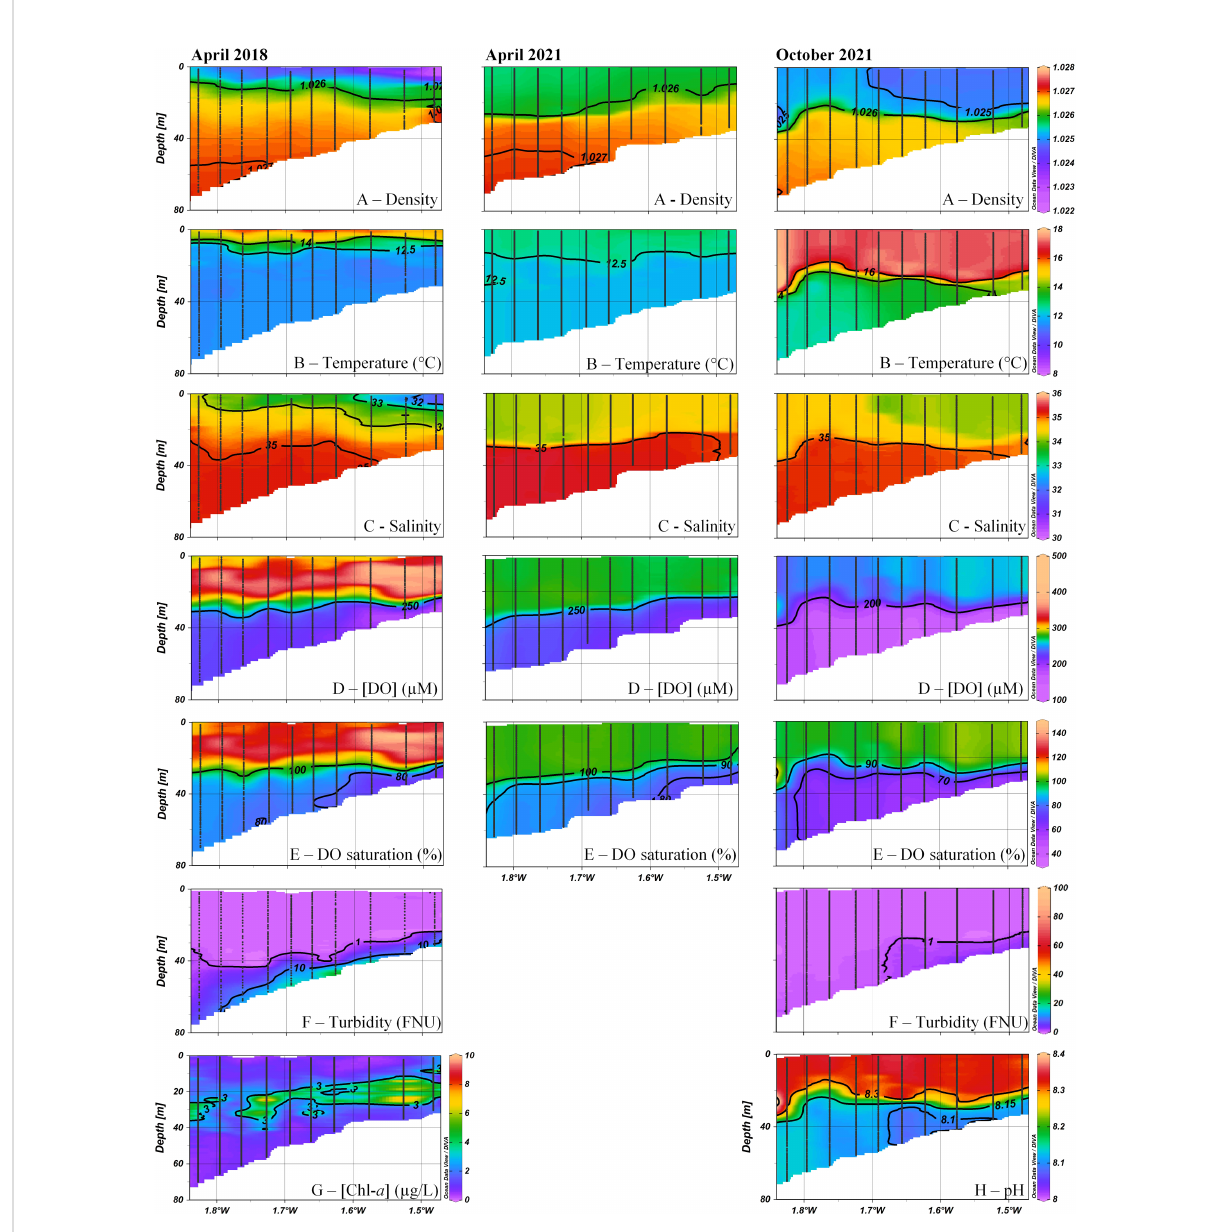
FIGURE 2 Transects (10 sites, from station 0 to 4) of density, temperature, salinity, dissolved oxygen (DO) concentrations and saturations, turbidity, Chl- a (April 2018) and pH (October 2021) in the water column of the West Gironde Mud Patch against longitude at three different periods (i.e., April 2018 and 2021 and October 2021). Pro fi les were interpolated with the software Ocean Data View . Gray dots represent the measurements